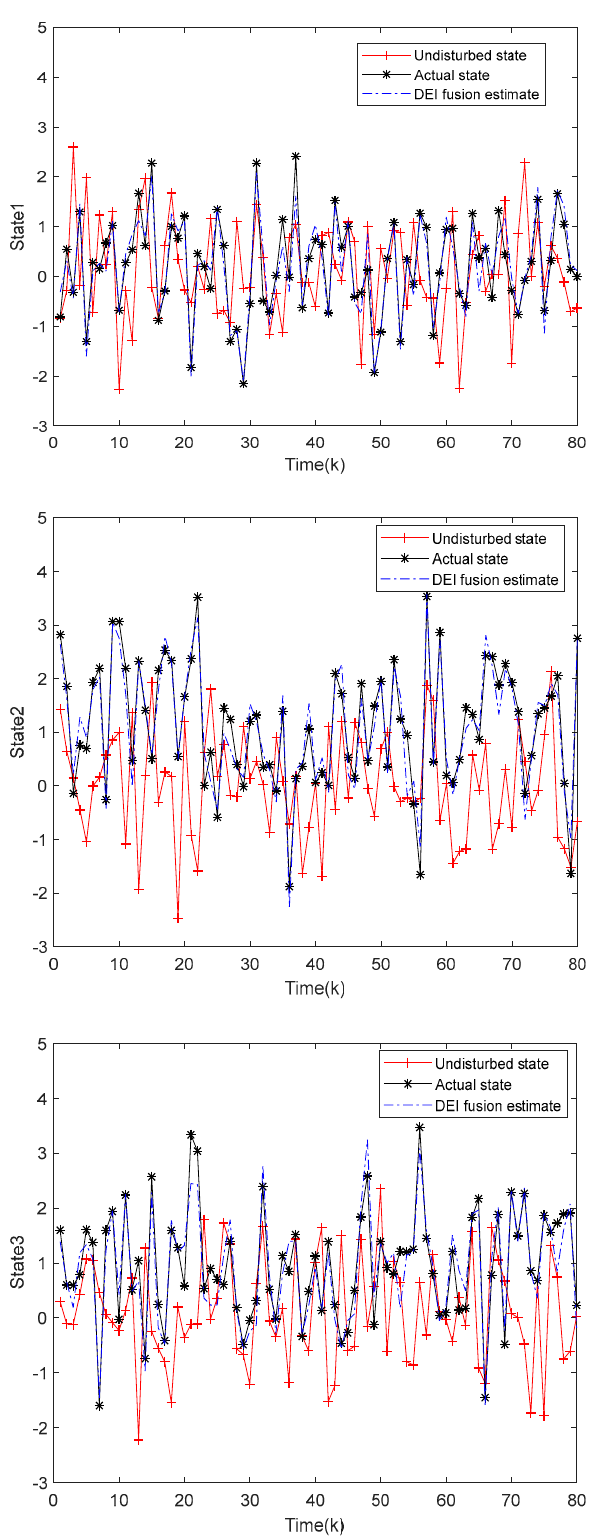
Figure 3. Performance of the Distributed Ellipsoidal Intersection (DEI) fusion estimator in the state estimation.